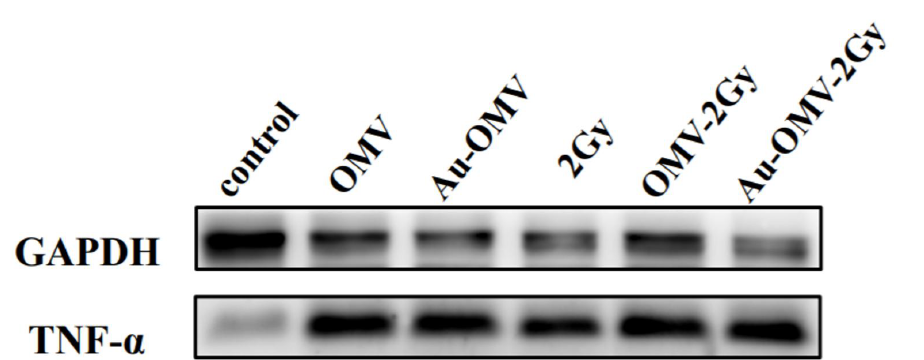
Figure 7. Western blot of TNF- α released from RAW 264.7 macrophages co-cultured with GL261 glioma cells. GAPDH was used as a loading